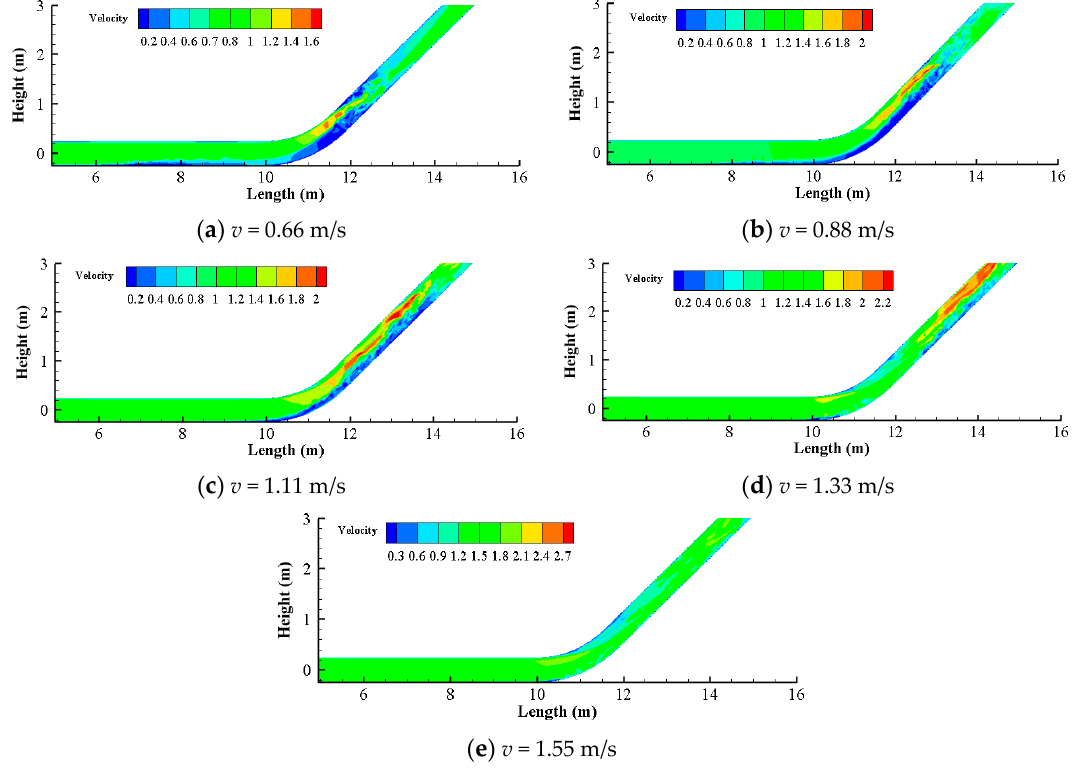
Figure 17. Contour of velocity distribution in pipe at α = 40° ( t = 11.0 s).